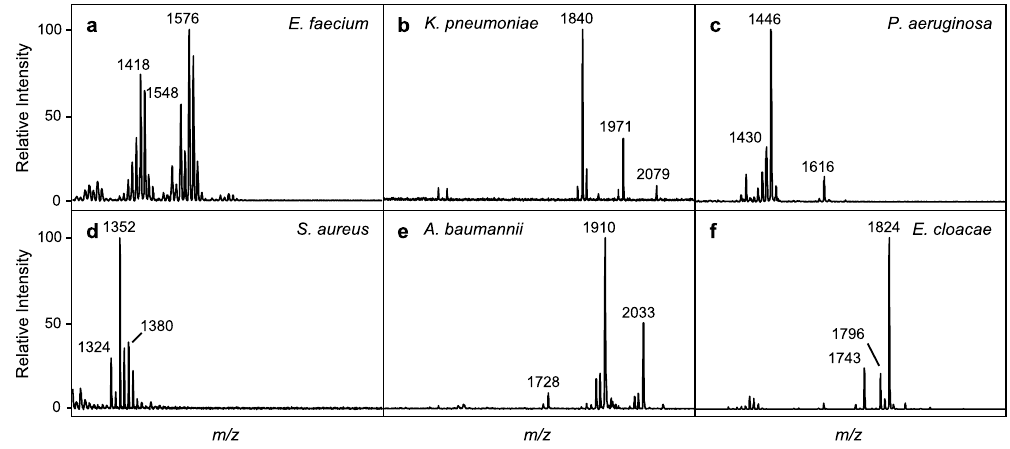
Figure 2. Representative mass spectra from ESKAPE pathogens: ( a ) Enterococcus faecium ; ( b ) Klebsiella pneumoniae ; ( c ) Pseudomonas aeruginosa ; ( d ) Staphylococcus aureus ; ( e ) Acinetobacter baumannii ; and, ( f ) Enterobacter cloacae. m/z values of select ions are